Question: Provide a publication-style caption for this figure.
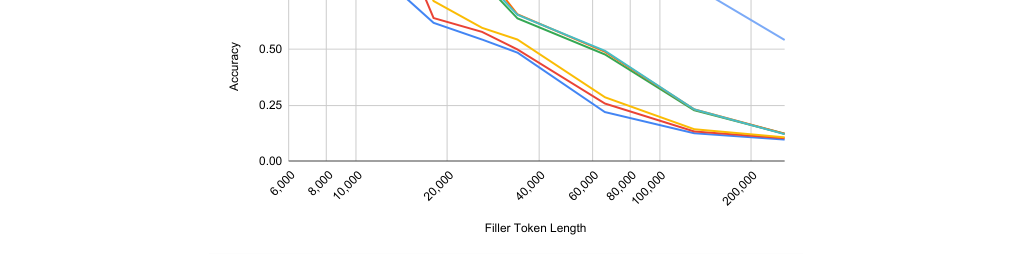
Answer: PassKey Retrieval Accuracy Using BSWA (M1,2,4), Feedback Memory Segments (FM1,2,4), Static Summary Tokens (SUM FAM) and FAM